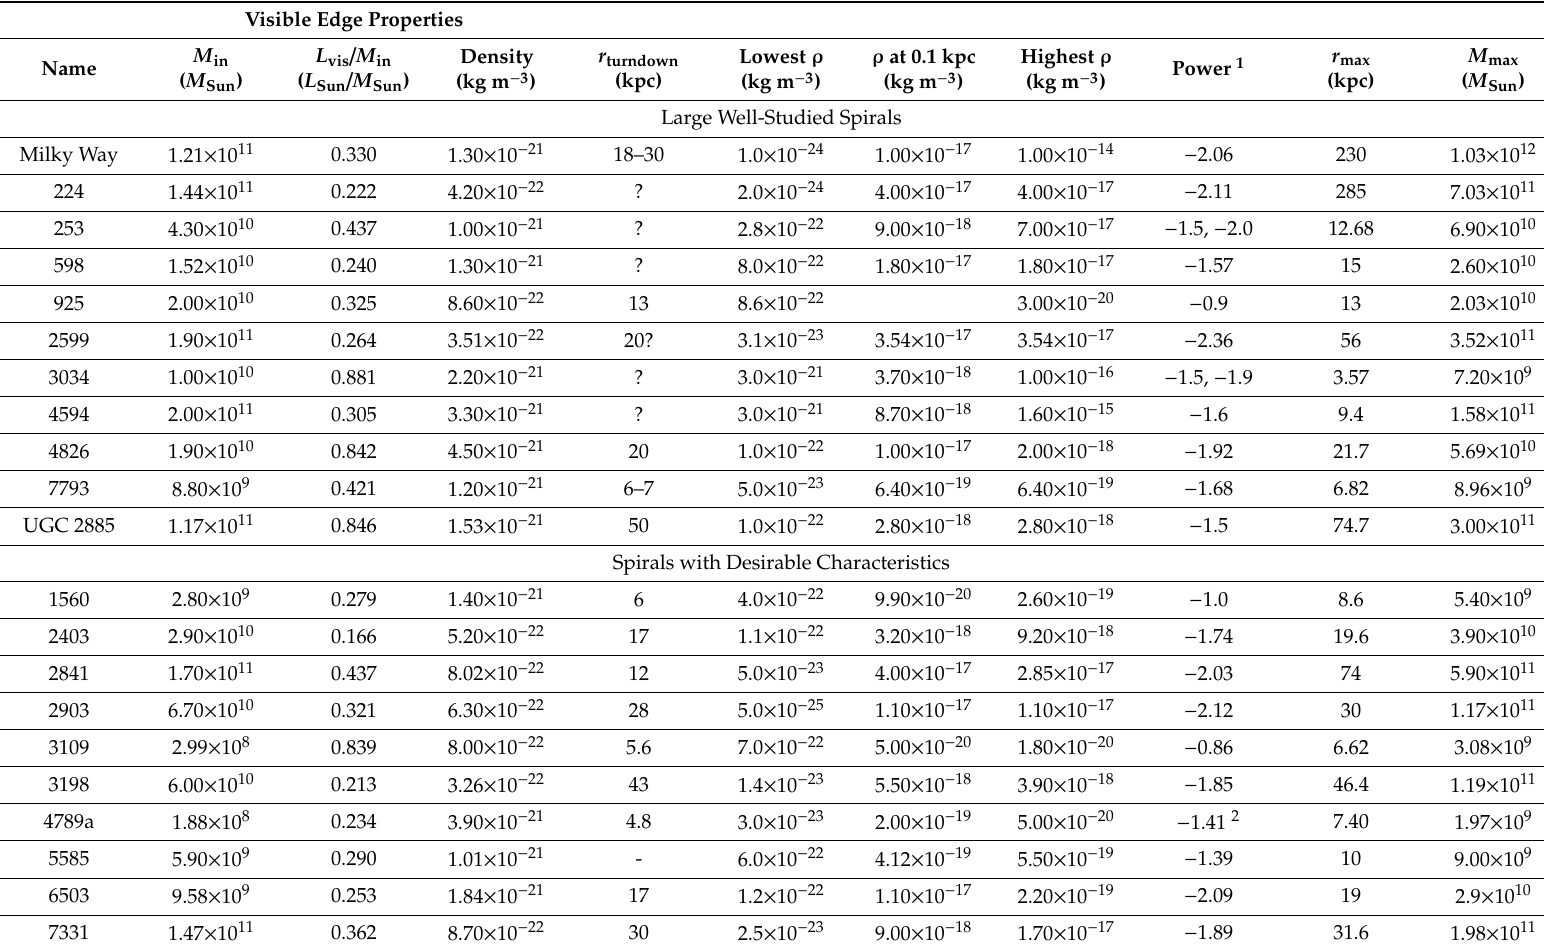
Table 5. Properties of galaxies extracted from rotation curves, with a focus on volumetric density. Visible Edge